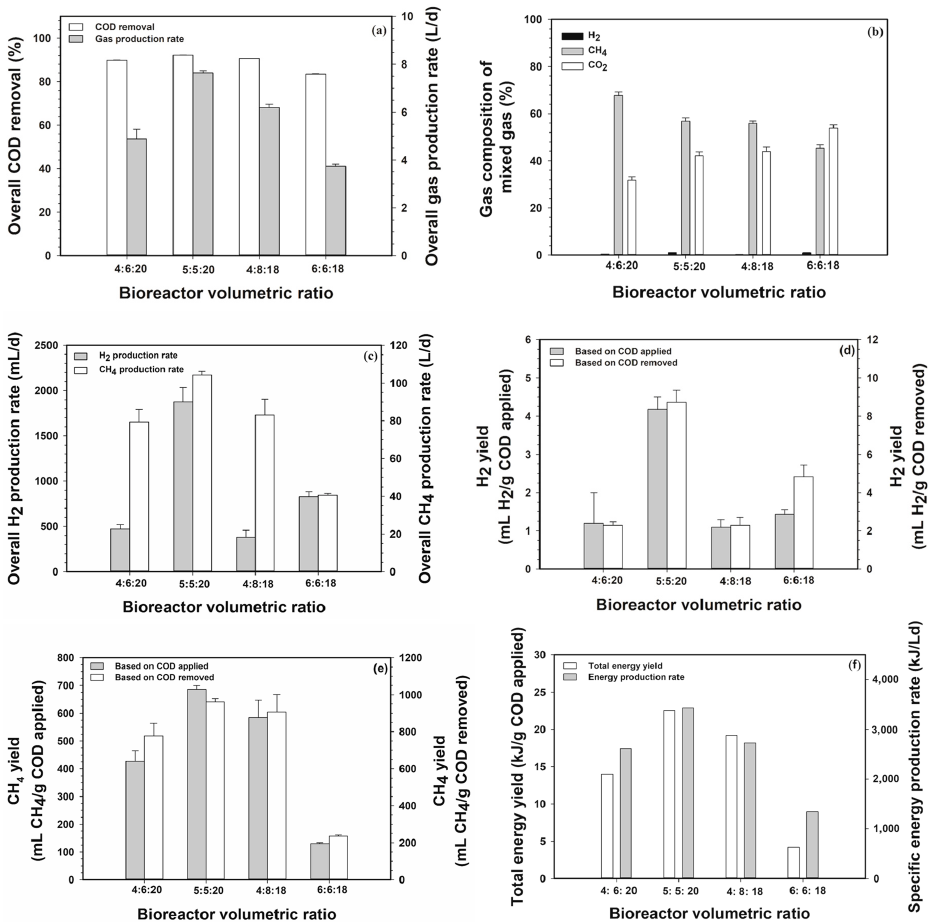
Figure 6. Effect of the bioreactor volumetric ratio on the ( a ) overall COD removal and overall gas production rate, ( b ) composition of mixed gas, ( c ) H 2 and CH 4 production rates of mixed gas, ( d ) H 2 yields, ( e ) CH 4 yields and ( f ) total energy yield and specific energy production rate of mixed gas when the three - stage ASBR system was operated at a COD loading rate of 18 kg / m 3 d, 37 °C and 8 cycles / d .